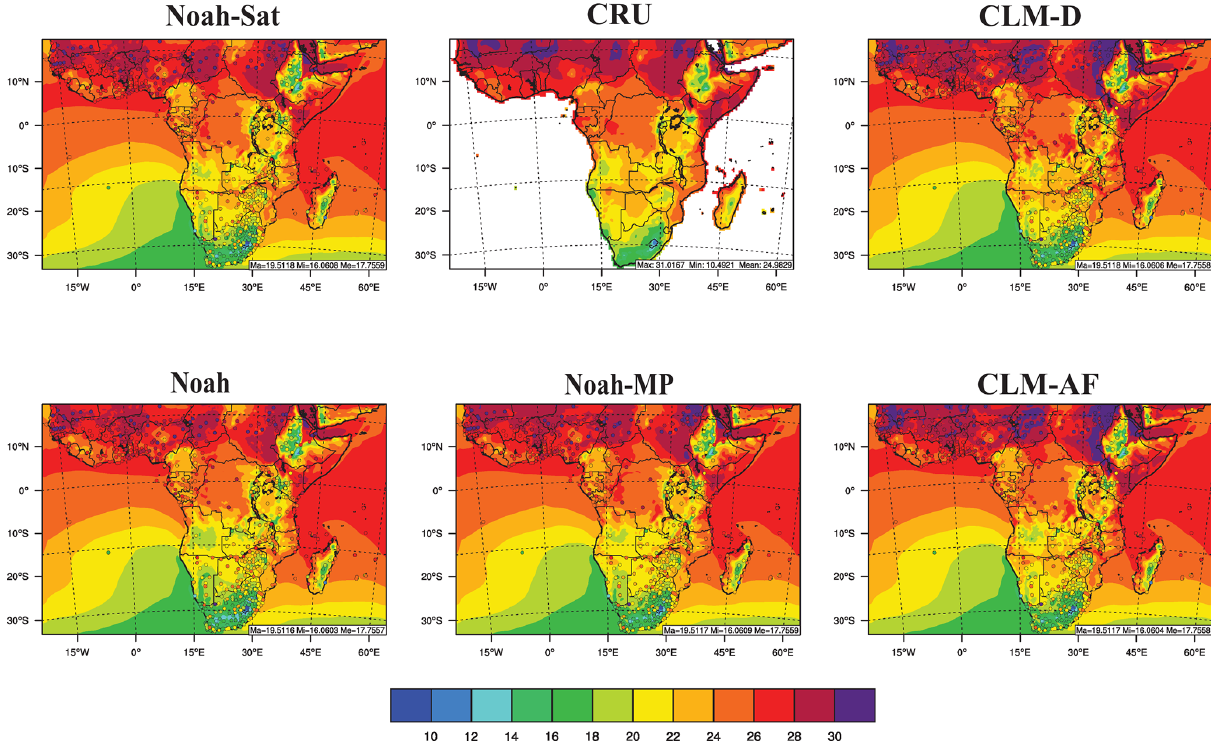
Figure 9. Year 2013 annual average 2m temperature ( ◦ C) from CRU and WRF simulations with five different LSMs. NCEI-ISD 2m temperature observations are